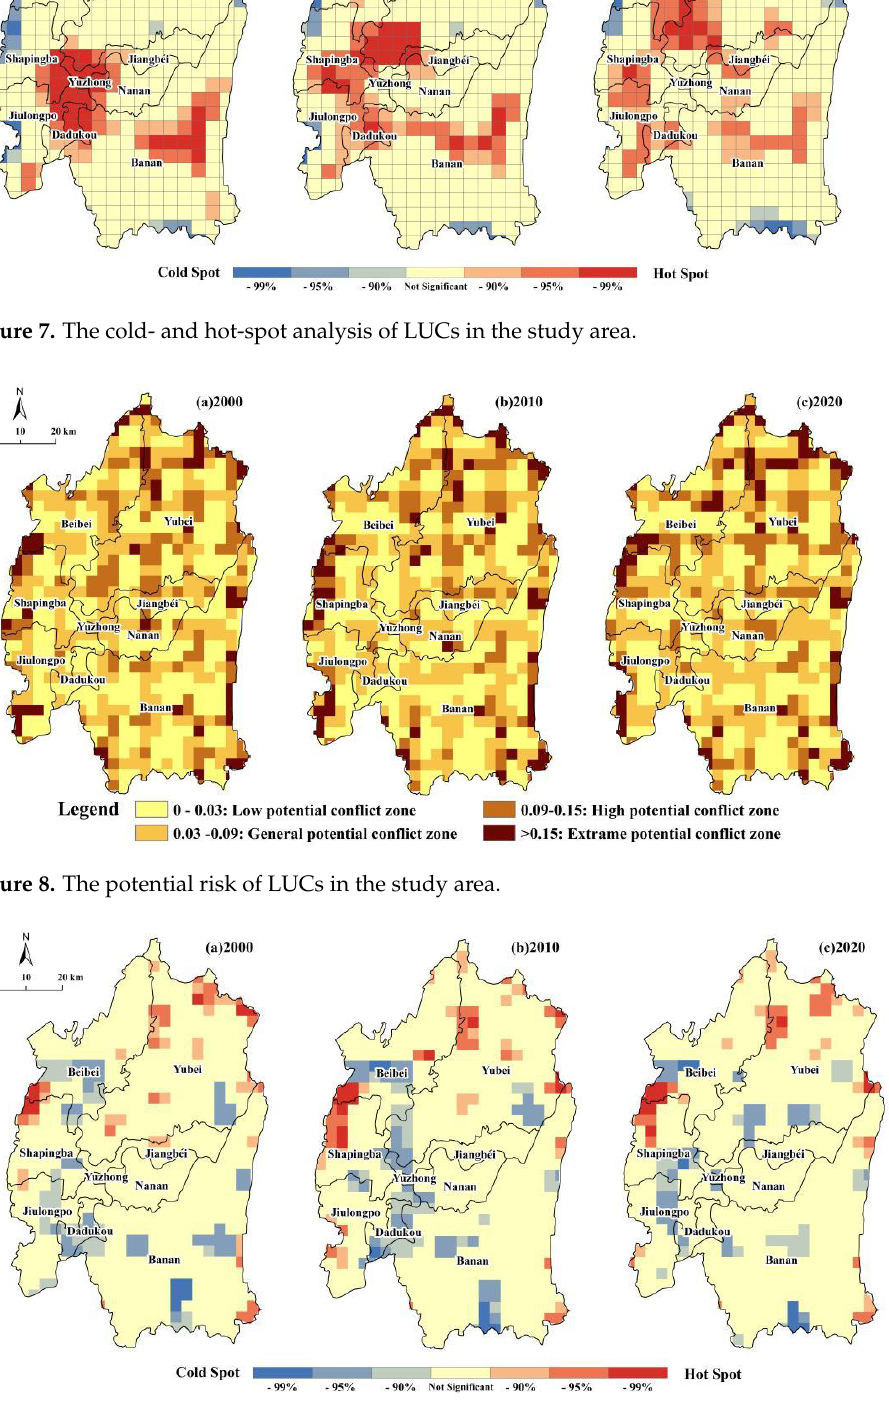
Figure 9. The cold – and hot – spot analysis of PLUCRI in the study area .